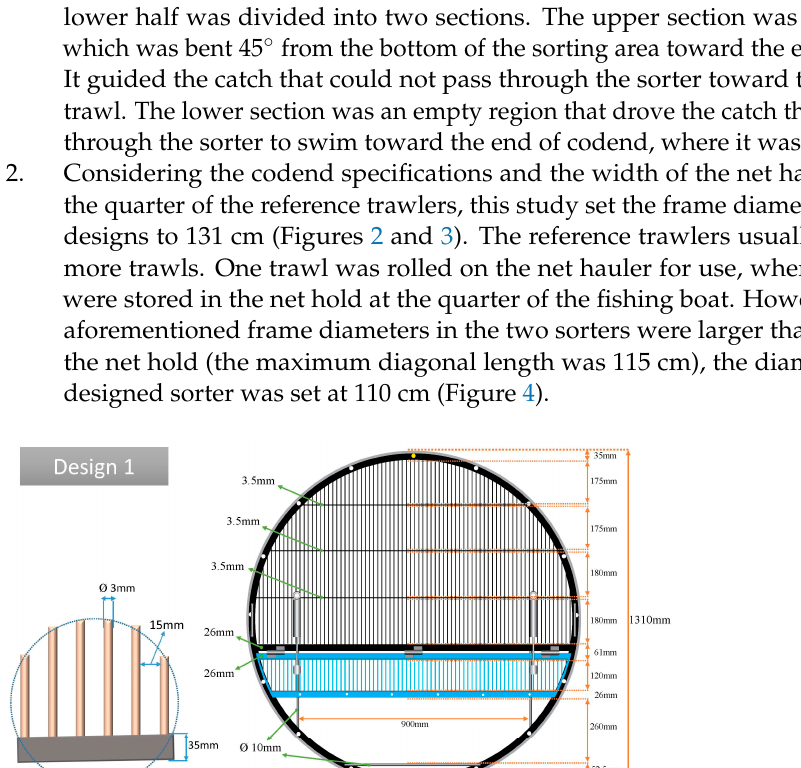
Figure 2. First JTED sorter design for Taiwanese bottom trawlers with single boat bottom otter trawls.